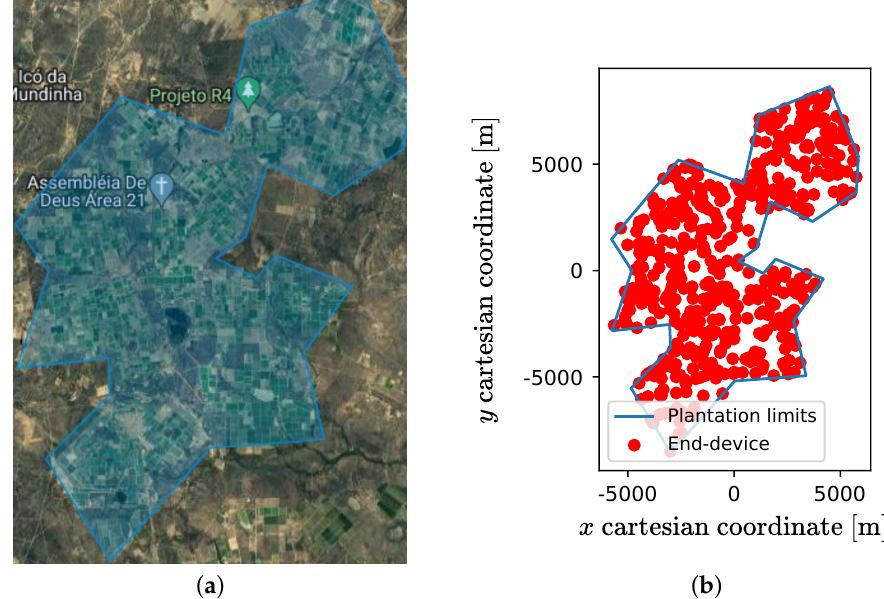
Figure 3. ( a ) Google Earth screen capture of the Nilo Coelho Project irrigation complex in Brazil, and ( b ) its projection to Cartesian coordinates.